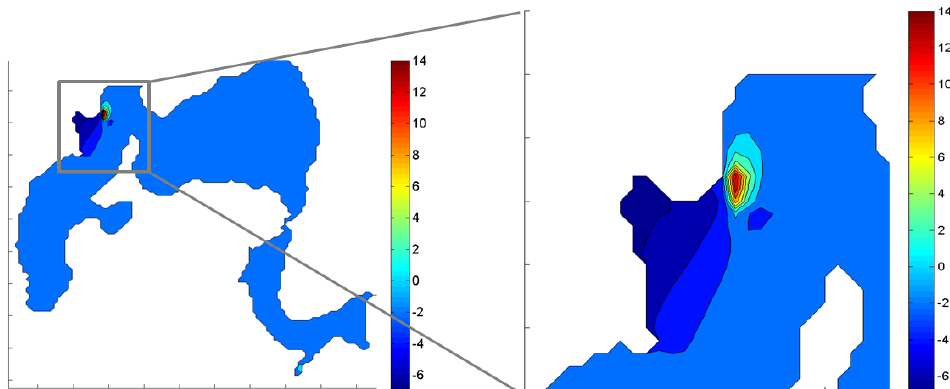
Fig. 6. Modelled spatial effect of mitigation cultures on sedimentation rates. Results are shown as the relative change (%) be- tween simulations with and without a mussel mitigation farm. Positive values indicate an increased sedimentation compared to a situation without compensation cultures, whereas negative values indicate decreased was removed by terrestrial measures. For K used to remove (organically bound) nutrients com- , the d pared to more traditional measures re sulting in nutri- ent load reductions from land (Fig. 8). The relative change in chl a was 37 × 10 −3 % per t of N removed when nitrogen was removed by mussels, whereas the change was 8 × 10 −3 % per t of N removed when N